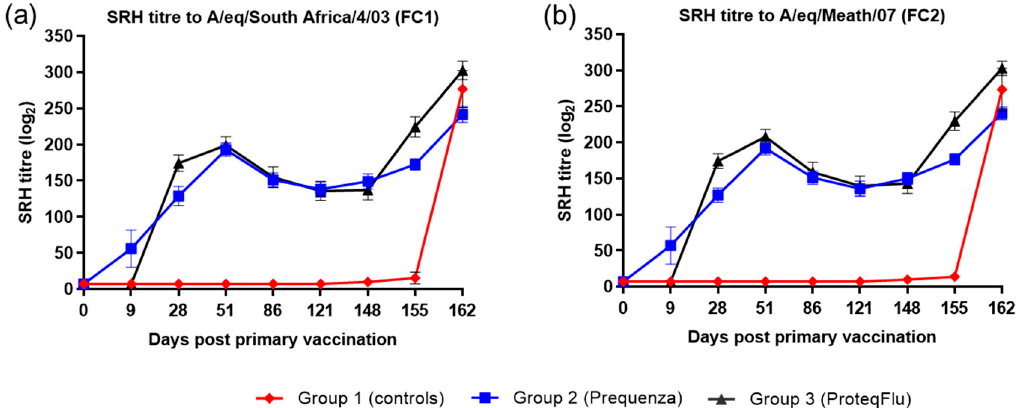
Figure 1. Mean single radial haemolysis (SRH) antibody titre response in groups 1–3 against H3N8 EIV ( a ) A / equine / South Africa / 4 / 03 (FC1) and ( b ) A / equine / Meath / 07 (FC2). Day 0, V1; Day 28, V2; Day 148, challenge. Red diamond = group 1, unvaccinated control group; blue square = group 2, Equilis Prequenza-vaccinated group; black triangle = group 3, ProteqFlu-vaccinated group. Error bars represent SEM.